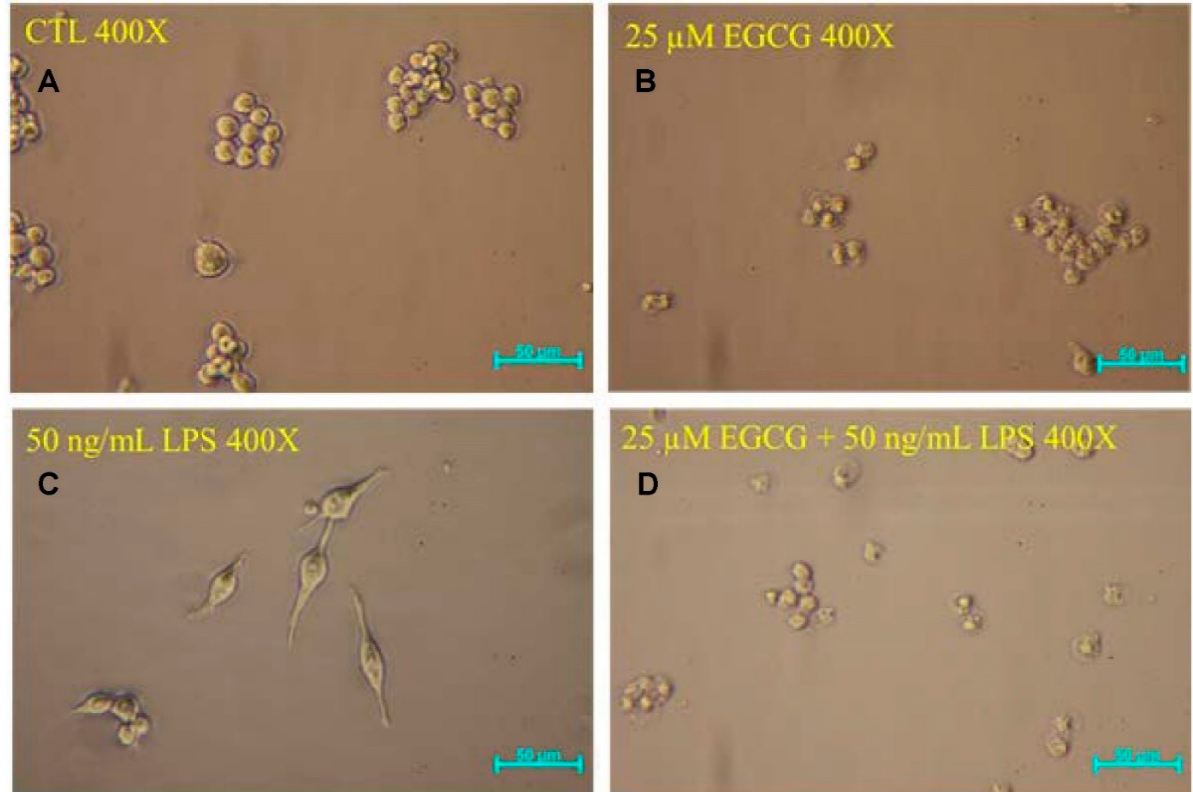
Figure 2. Morphology of BV-2 cells ( A ) of the control group, ( B ) treated with EGCG, ( C ) treated with LPS, and ( D ) treated with EGCG and then LPS.